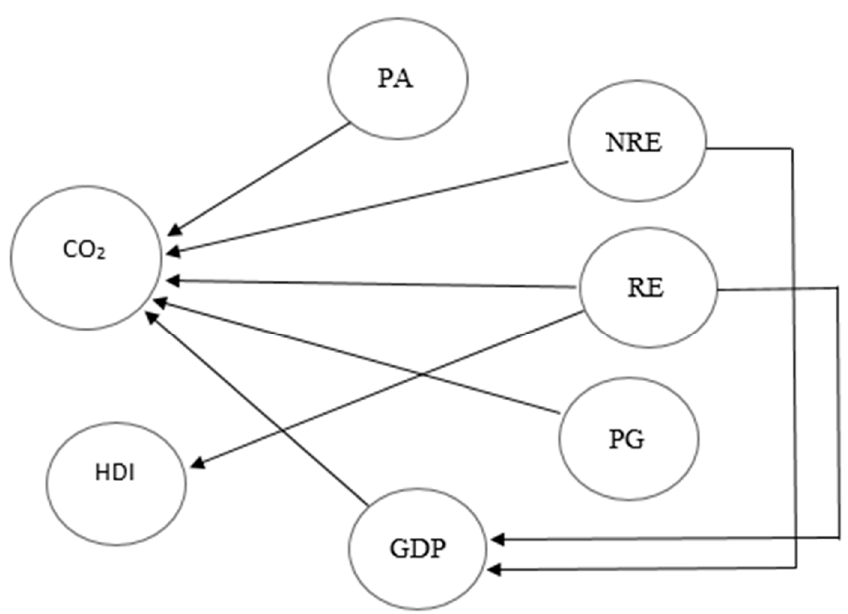
Figure 3. Short-run causality analysis. Int. J. Environ. Res. Public Health 2020 , 17 , x